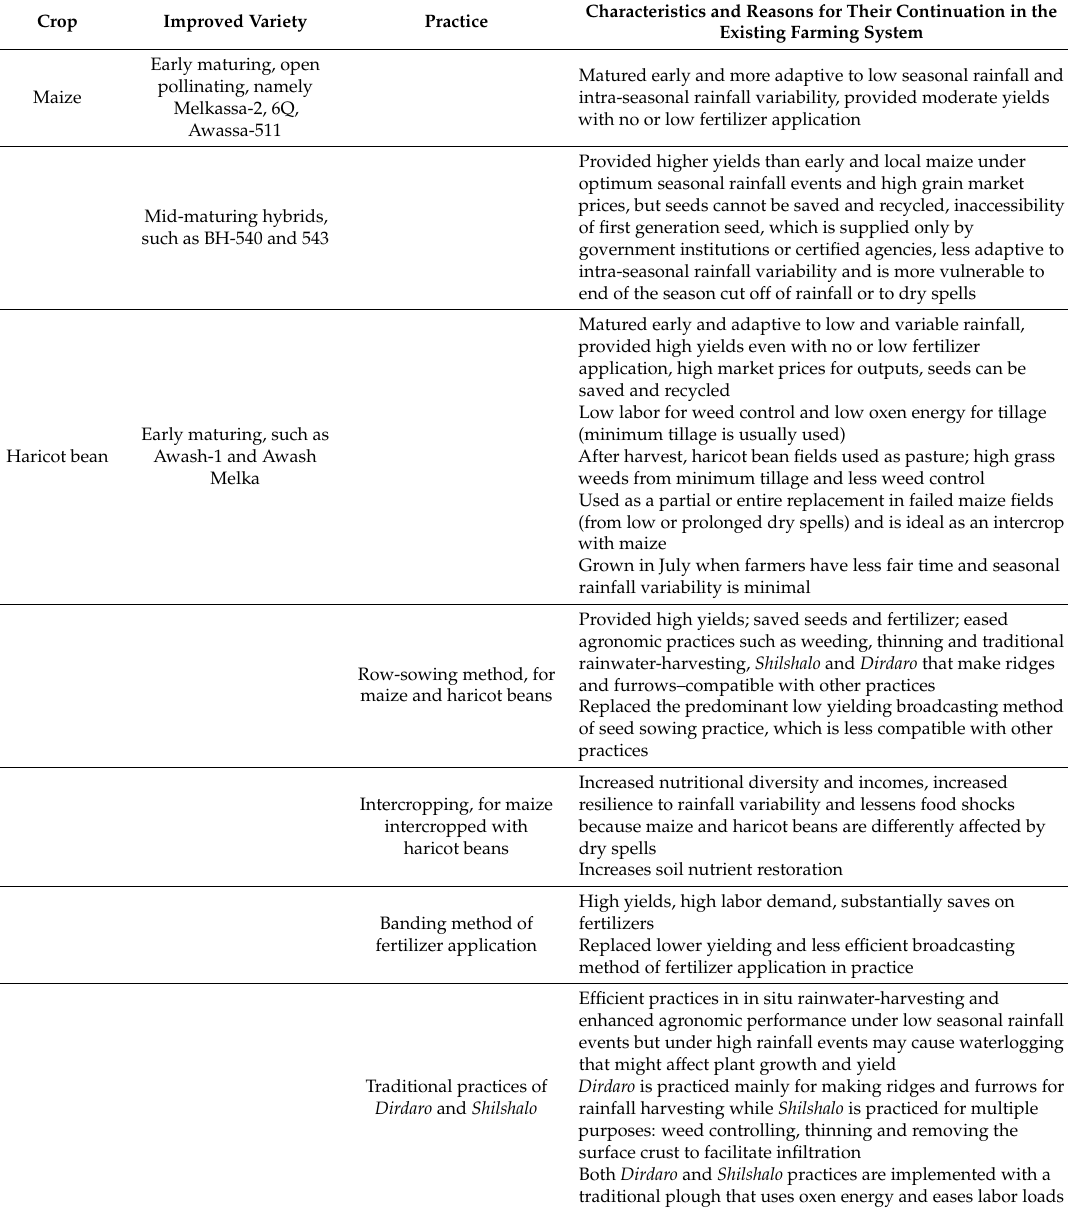
Table 1. Continued improved crop varieties and agricultural practices, key characteristics and reasons for their continuation in the agricultural